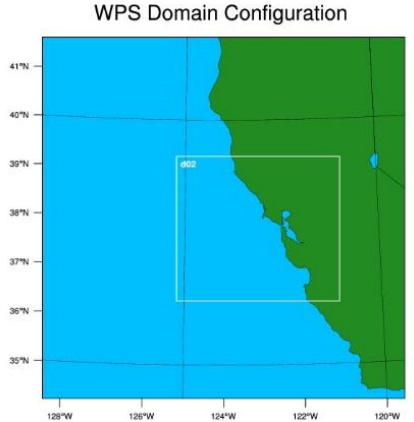
Figure 4. Domain used for our WRF simulations. Inner domain (“d02”) is designed to cover both the SFBA, and the immediate offshore waters.